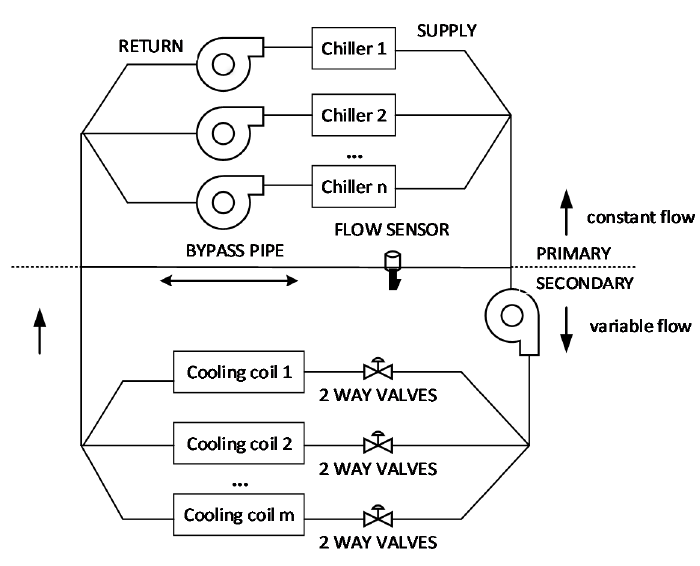
Figure 1. Structure of the decoupled system.